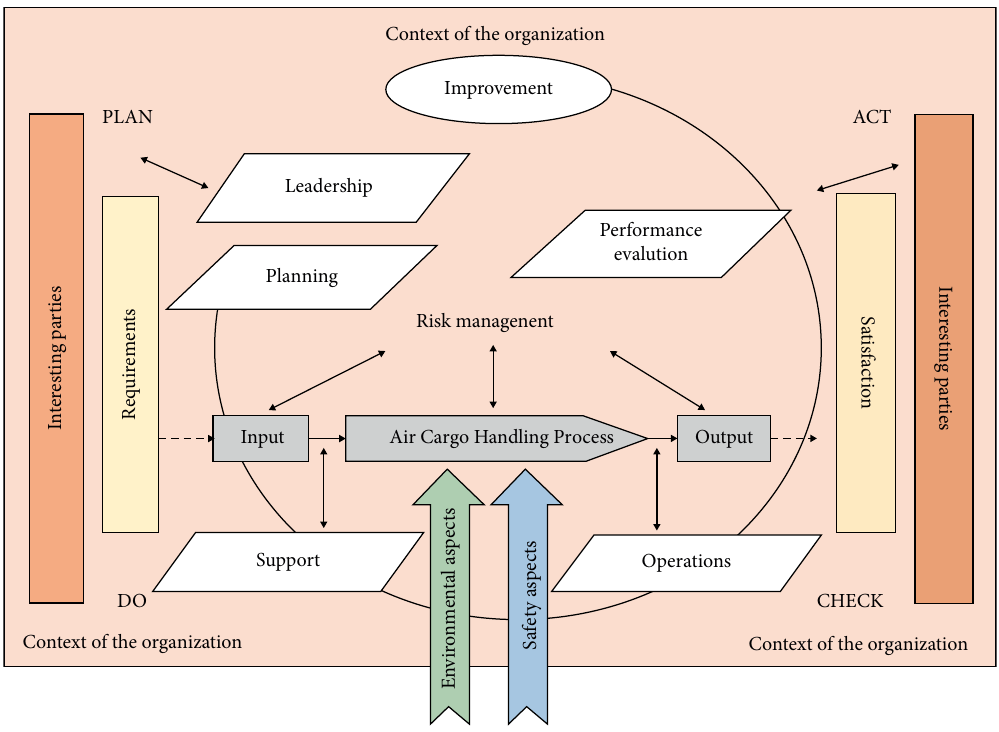
Figure 6: A model of the functionality of the management system within which ACHP takes place.